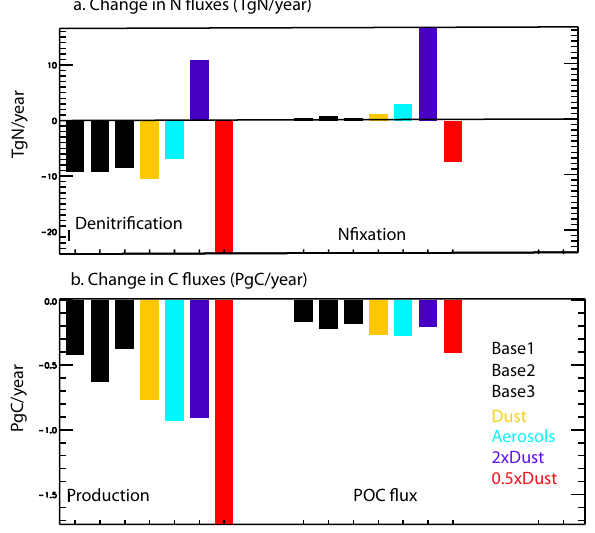
Fig. 4. Change in ocean fluxes for (a) the Nitrogen cycle (Tg Nyear − 1 ) and the (b) Carbon cycle (Pg Cyear − 1 ). For the nitrogen cycle we consider denitrification and nitrogen fixation. For the car- bon cycle, we consider productivity, and particulate organic carbon flux at 103m. These represent changes between 2080–2099 and the preindustrial control for each